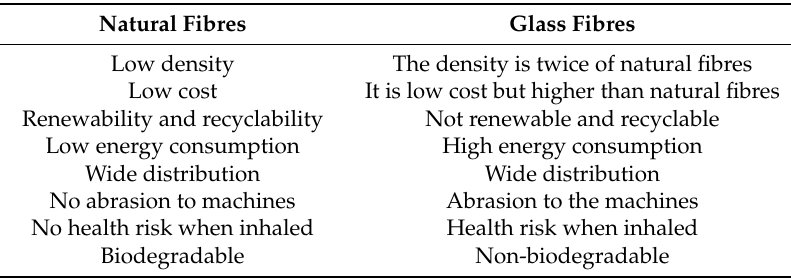
Table 1. Comparison between natural and glass fibres [12].